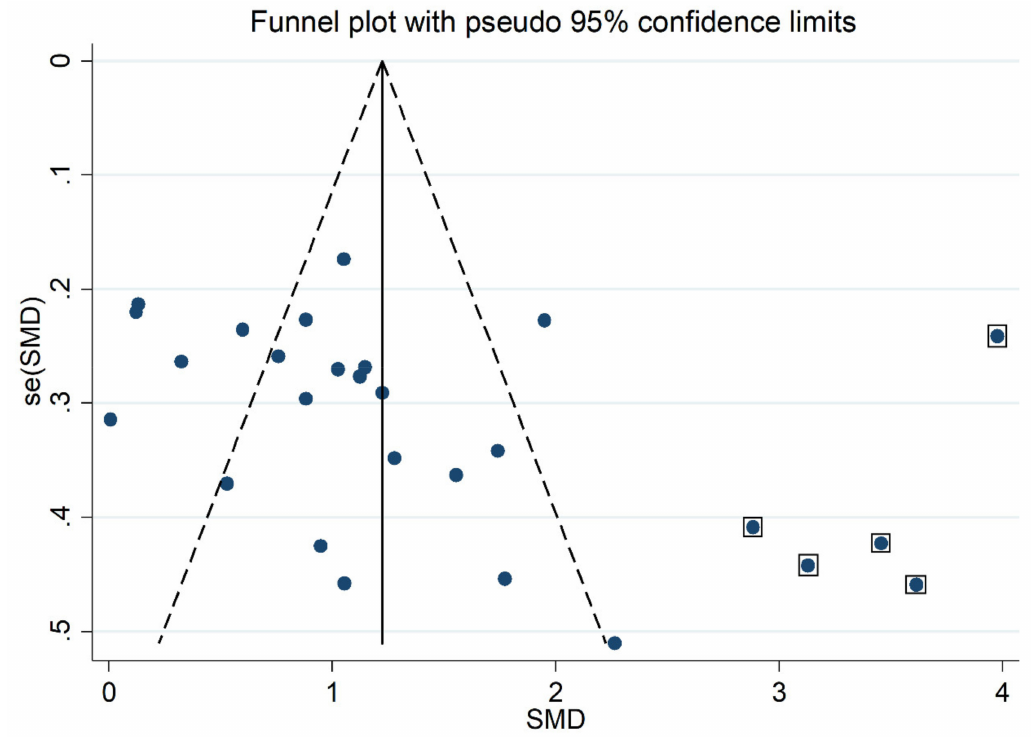
Figure 4. Funnel plot of studies investigating MDA concentrations in OSA. The enclosed circles represent the five studies with a likely distortion effect on the funnel plot symmetry.